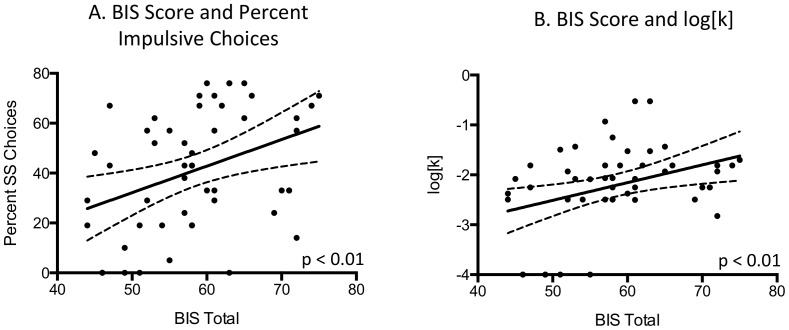
Associations between BIS total score and (A) percentage of impulsive choices, and (B) change in k value, both under the ‘no influence’ condition.There were no slope differences between the ‘no influence’ condition and any influence conditions. Dotted lines represent the 95% confidence interval of the associations.